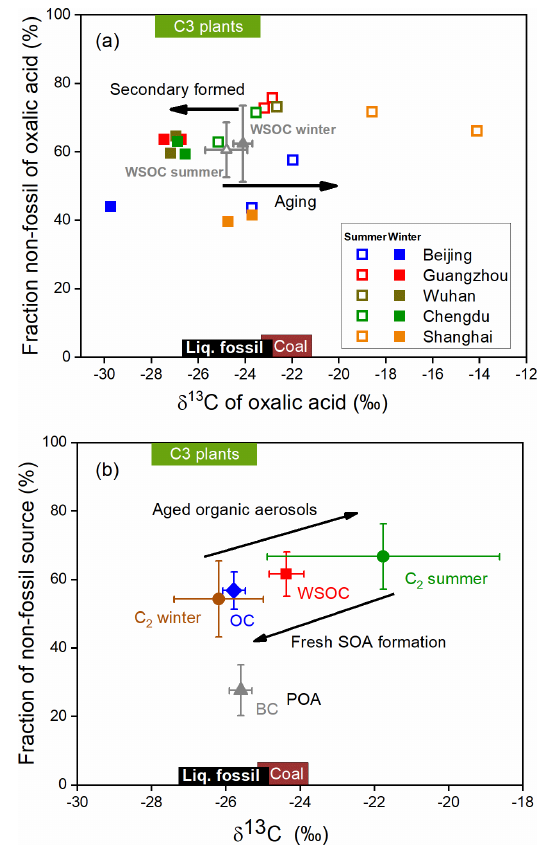
Figure 5. 14 C-based non-fossil source fractions plotted against the δ 13 C values for molecules and carbonaceous aerosol components. (a) Aerosol oxalic acid collected in Beijing (blue), Guangzhou (red), Wuhan (brown), Chengdu (green), and Shanghai (orange) in summer (open squares) and winter (filled squares). The mean dual- carbon isotope signals for water-soluble organic carbon (WSOC) in the five cities in summer (open gray triangles) and winter (filled gray triangles) are also shown (Fig. S4). Each error bar indicates the standard deviation. (b) Annual-mean values for black carbon (BC, gray triangles), organic carbon (OC, blue diamonds), WSOC (red squares), and oxalic acid (C 2 , brown and green circles) in the five cities (see Table 1 for detailed data and references). Each error bar indicates the standard deviation. Here POA and SOA refer to pri- mary organic aerosol and secondary organic aerosol,